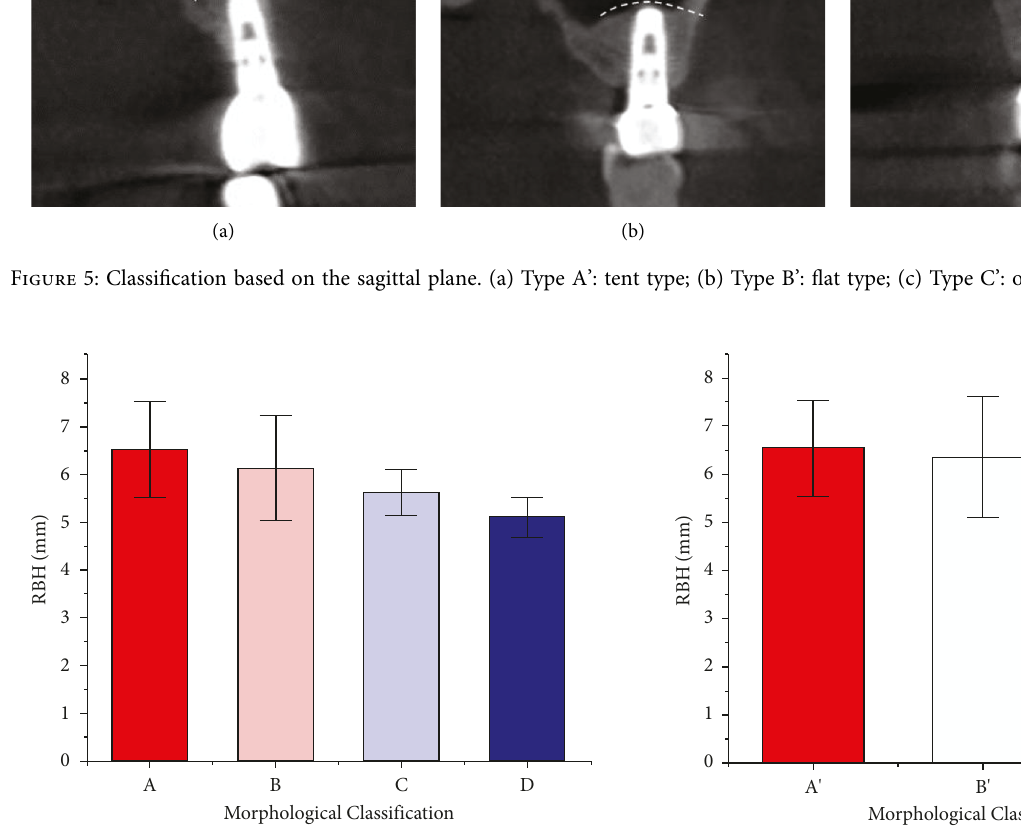
Figure 7: The mean RBH of different morphological classifications based on the coronal plane ( p < 0 . 05, power � 0.63). (a) Type A’: tent type; (b) Type B’: flat type; (c) Type C’: one-sided dehiscence